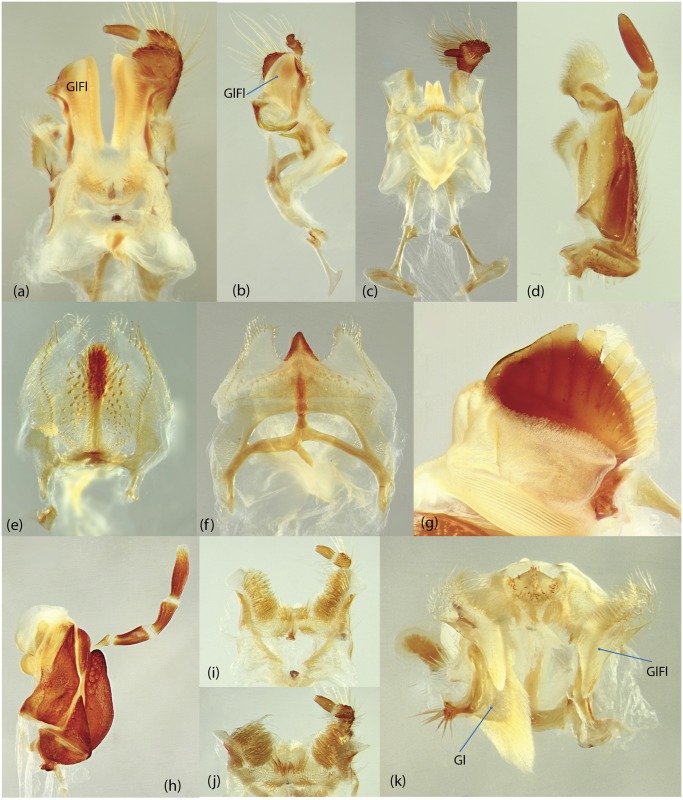
Mouthparts of Scarabaeinae.a,b,e, Chalcocopris hesperus; c,f, Glyphoderus monticola; d, Scatonomus fasciculatus; g,h, Eucranium arachnoides; i,j, Ateuchus squalidus; k, Megathoposoma candezei; a,c,i, hypopharynx and glossae, dorsal view, left maxillary palpus removed; b, hypopharynx and glossae, left lateral view; d,h, left maxilla, ventral view; e, epipharynx, ventral view; f, epipharynx, dorsal view; g, molar lobe of right mandible; j, hypopharynx and glossae, fronto-dorsal view, left maxillary palpus removed; k, hypopharynx and glossa, frontal view, both maxillary palpus removed, left glossa also removed.